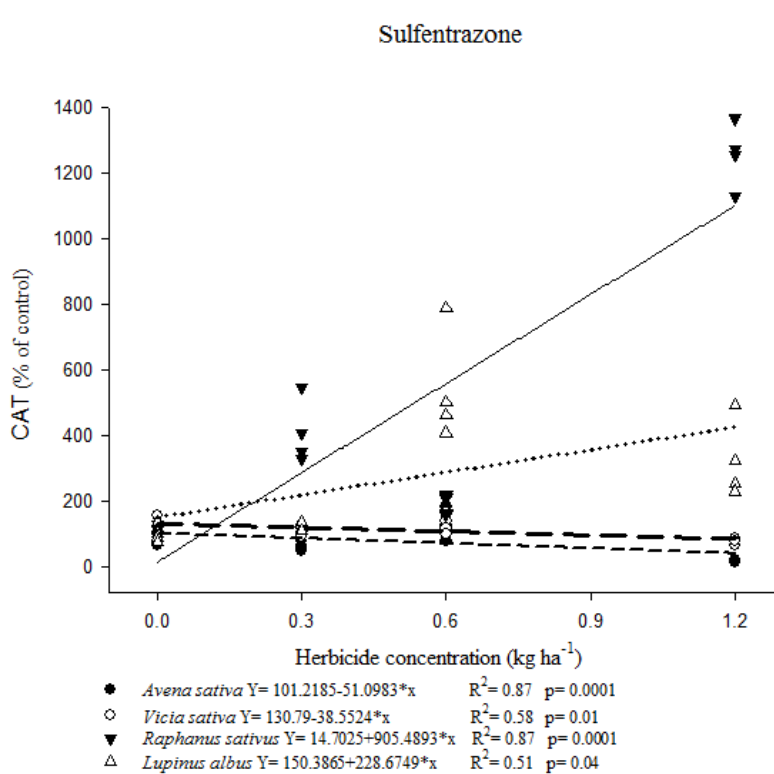
Figure 2 - Effect of sulfentrazone on catalase (CAT) activity in different crop plants.